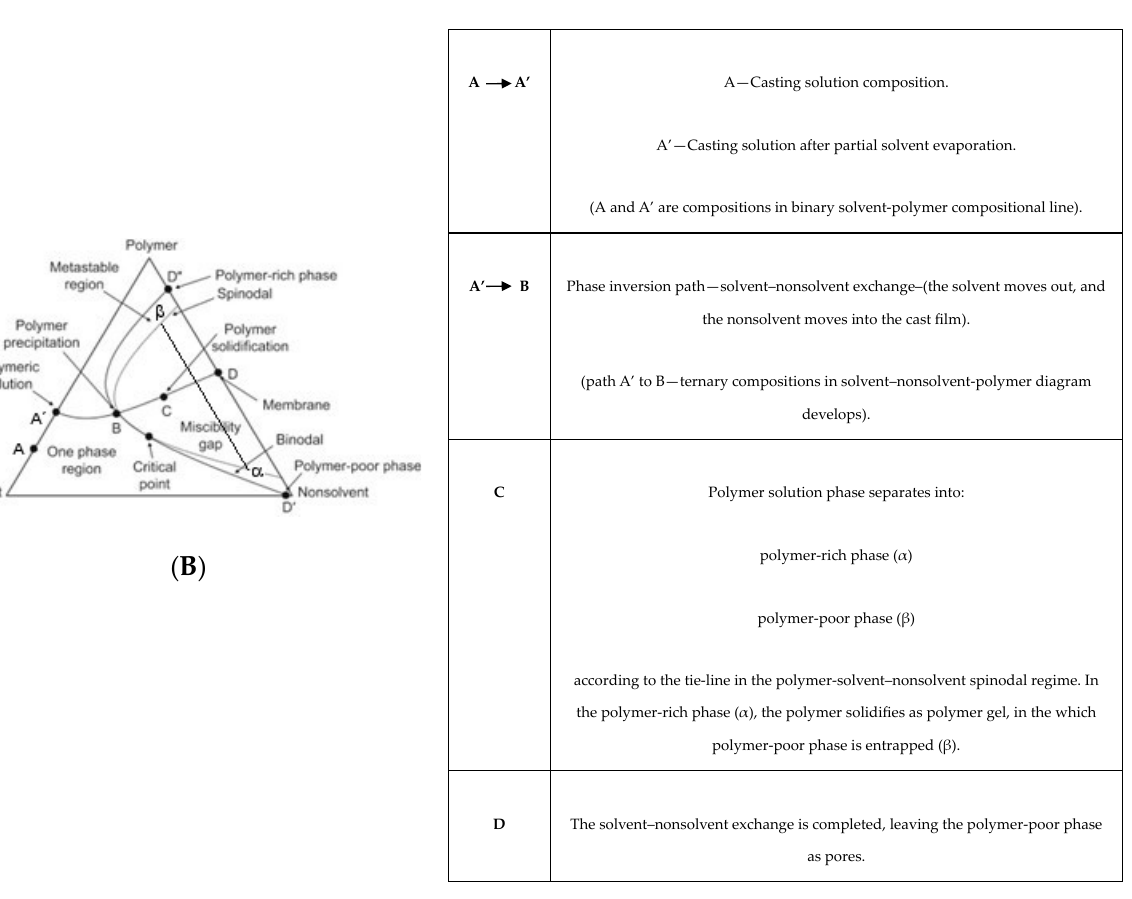
Figure 1. Polymer-solvent–nonsolvent system: ( A ). Classical Loeb–Sourirajan method setup; ( B ). Ternary phase diagram. ( B ). Ternary phase